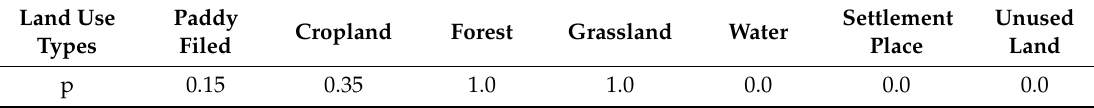
Table 1. P -values of di ff erent land use types.